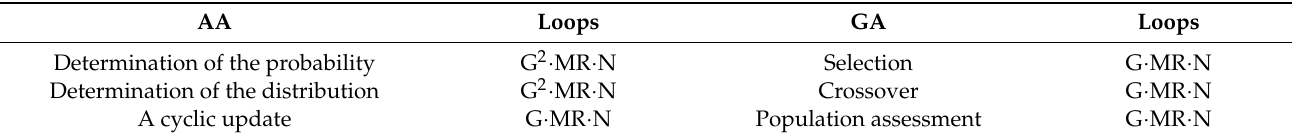
Table 4. The main loops in the algorithms.